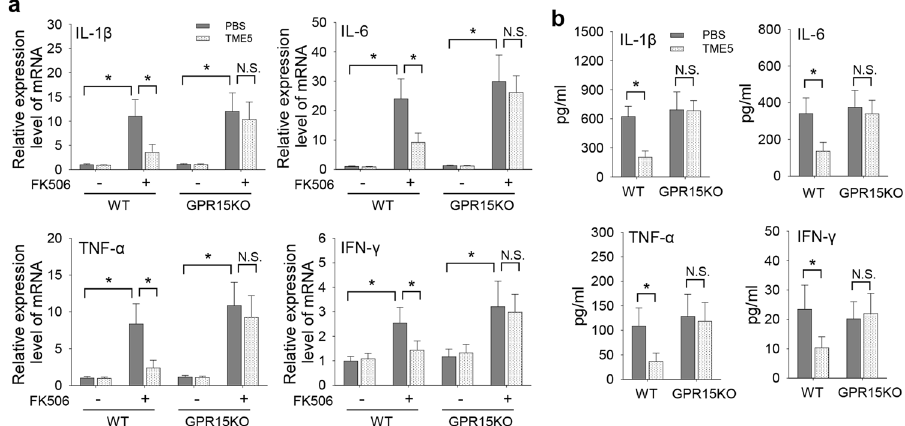
Figure 6. TME5 suppressed production of pro-inflammatory cytokines in FK506-treated murine ECs. Murine ECs from WT or GPR15 KO mice were treated with FK506 (10 μ g/ml), in the presence of PBS or TME5 (250 ng/ ml) for 48 hrs. ( a ) RNAs were extracted from cells and were subjected to qPCR analysis for mRNA levels of IL-6, IL-1 β , TNF- α and IFN- γ . Data represent fold changes (n = 6 in each). ( b ) Supernatants of ECs culture were analyzed by ELISA or cytometric bead array for determining levels of IL-1 β , IL-6, TNF- α and IFN- γ . Data are shown as mean ± SD, and are compared using one-way ANOVA test. * p < 0.05; N.S., no